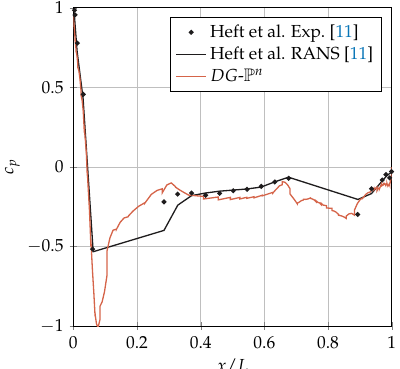
Figure 11. Simplified DrivAer model—Time-averaged pressure coefficient distribution on the sym- metry plane for the body ( left ) and underbody ( right ) of the car, high-Reynolds number.